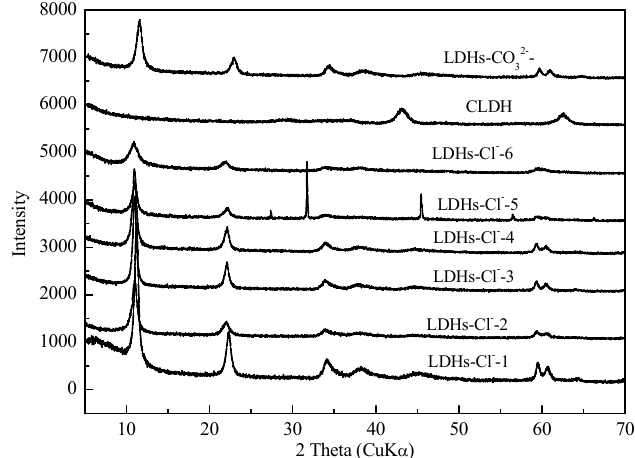
Figure 1. XRD patterns of Mg − Fe − Ti − LDHs and Mg − Fe − Ti − CLDH.